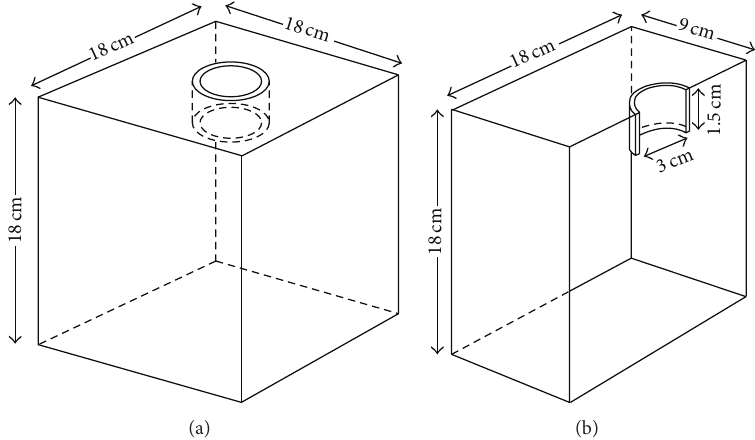
Figure 5: Schematic view of cubic Helmholtz resonators used in this project: (a) full view and (b) cross section view. For instance, RT60 was decreased from 2.6 seconds only to 2.4 seconds in 150 Hz and from 1.8 to 1.6 in 350 Hz.